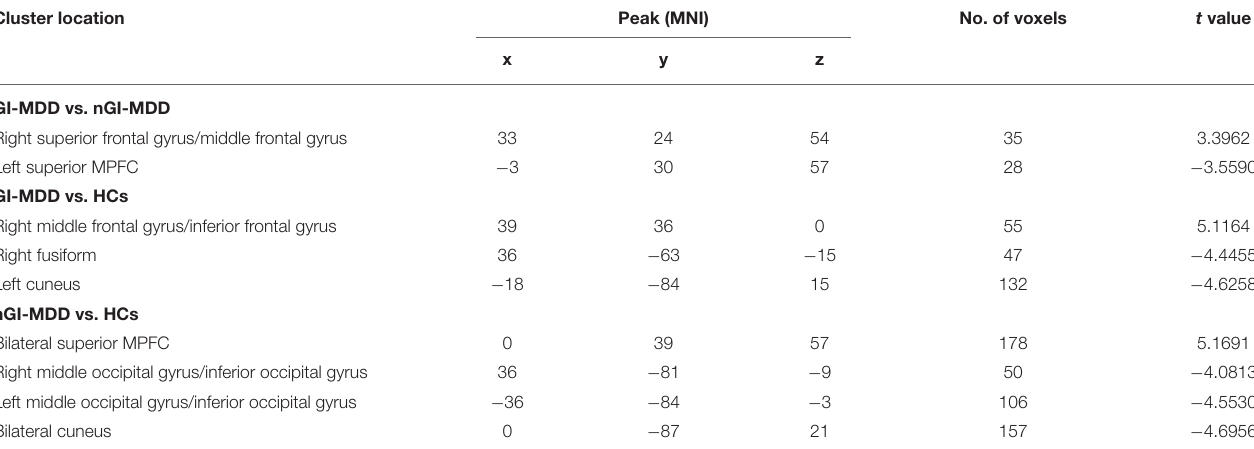
TABLE 2 | Significant fractional amplitude of low-frequency fluctuation (fALFF) differences across three groups. Cluster location Peak (MNI) No. of